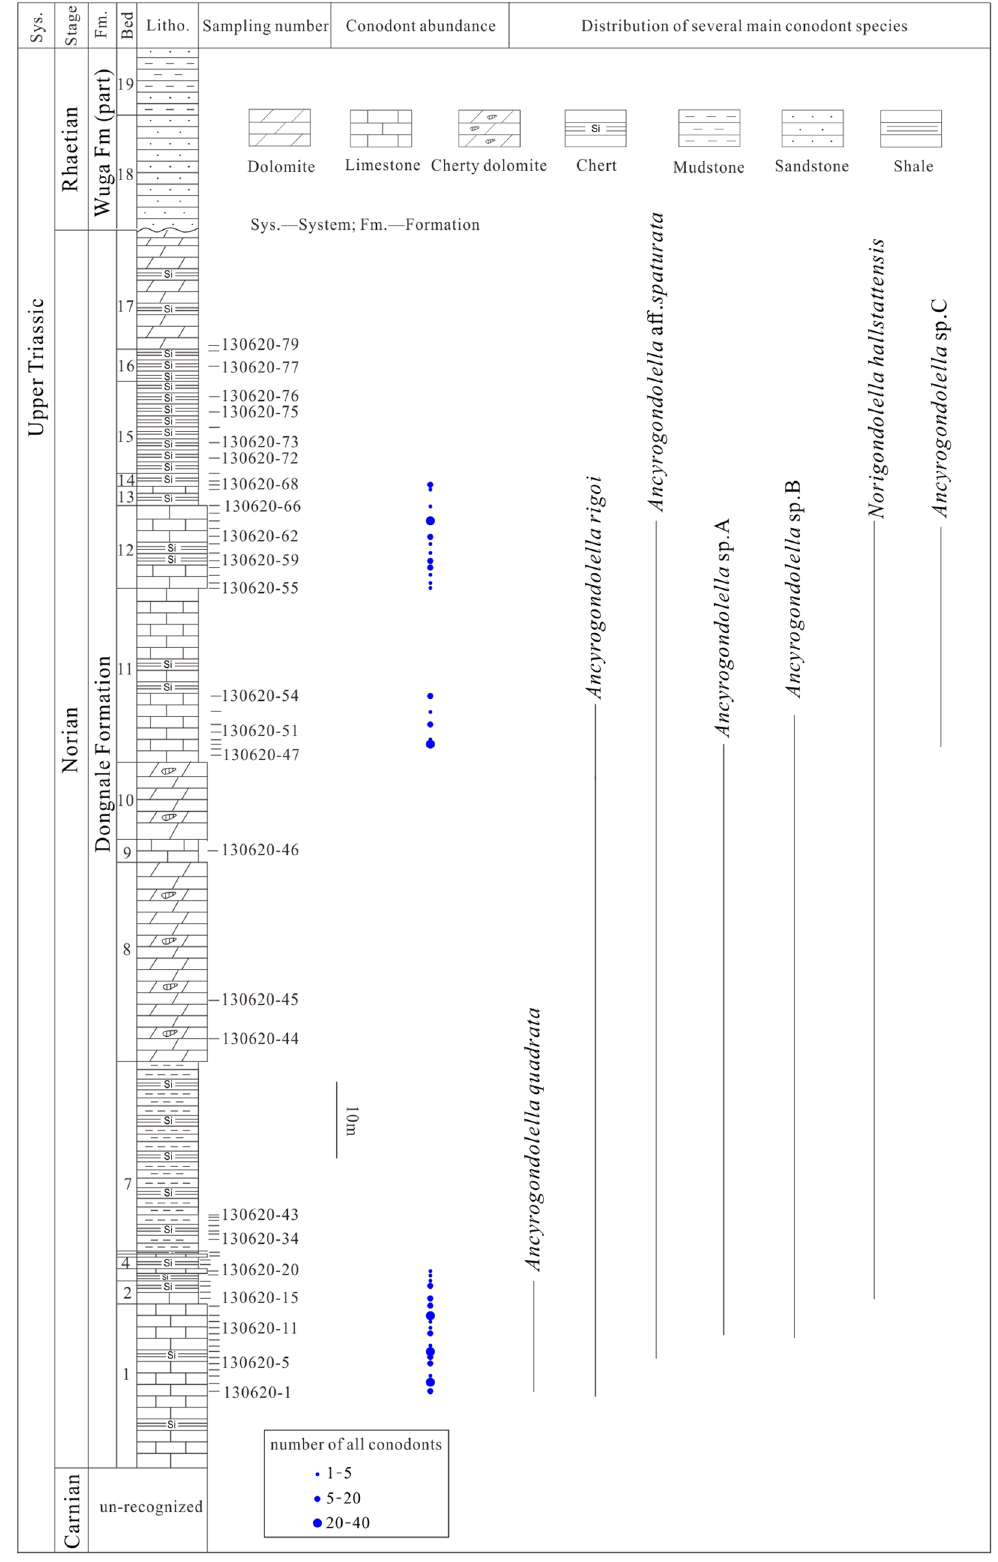
Figure 2. Lithologic log of the ZhaxicobuCo section illustrating the sample locations of conodonts and the principal conodont